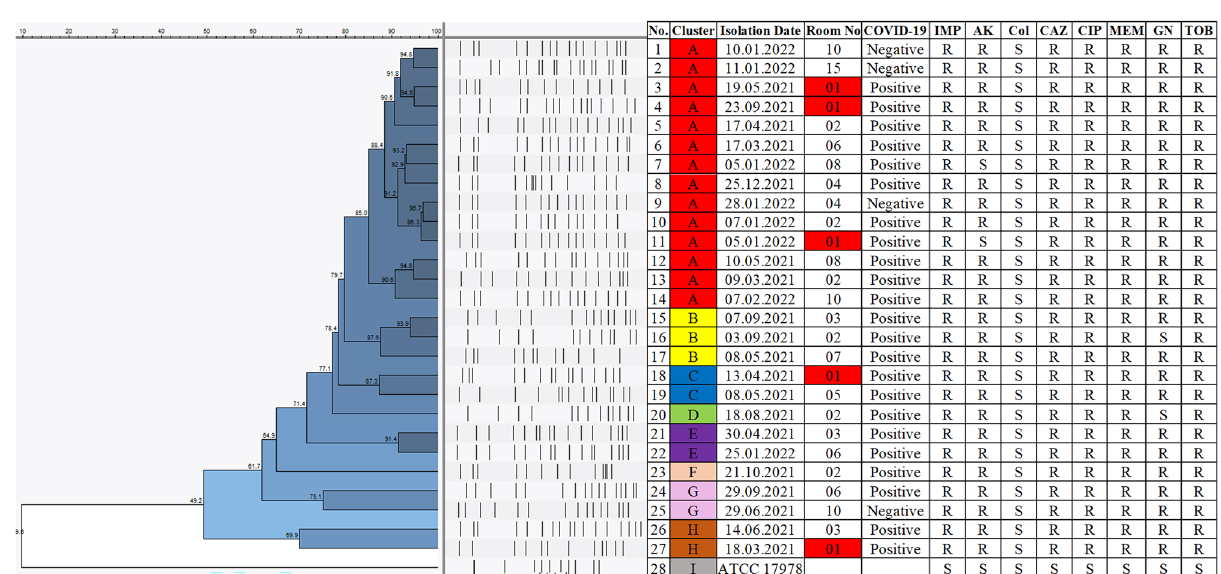
Figure 1. Cluster analysis of A. baumannii samples using PFGE results. Each color represents a different cluster of isolates. IMP, imipenem; AK, amikacin; Col, colistin; CAZ, ceftazidime; CIP, ciprofloxacin; MEM, meropenem; GN, gentamicin; TOB, tobramycin; R, resistant; S,